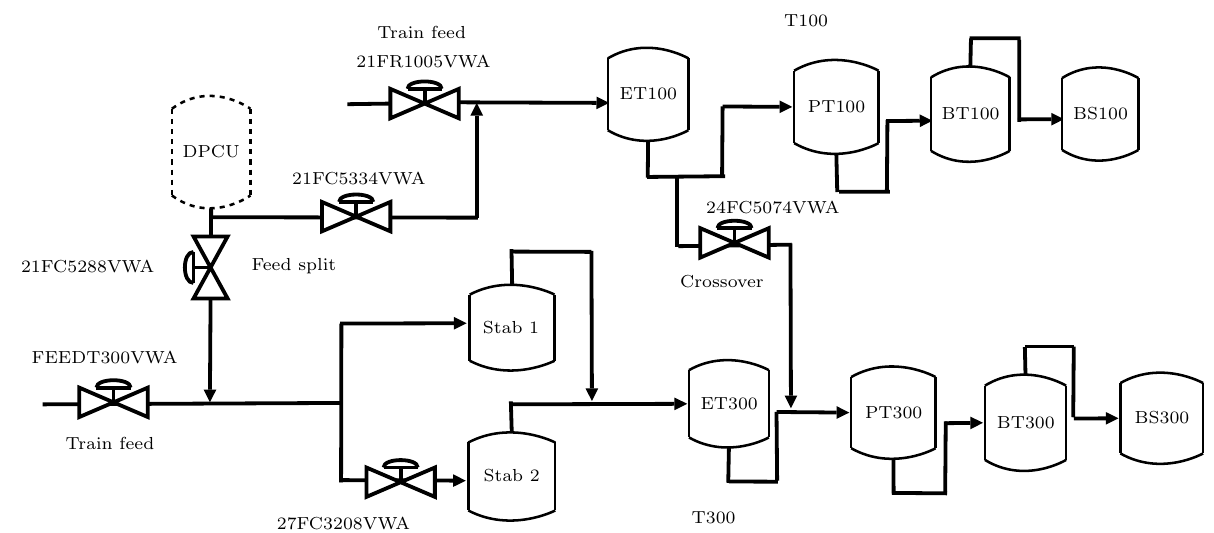
Figure 3: The simulated parts of the K˚arstø plant valves in Figure 3: two main train feeds, two liquid streams to the trains from the dew point control unit (DPCU), a crossover from train T100 to T300, and a flow split for the parallel stabilizers in train